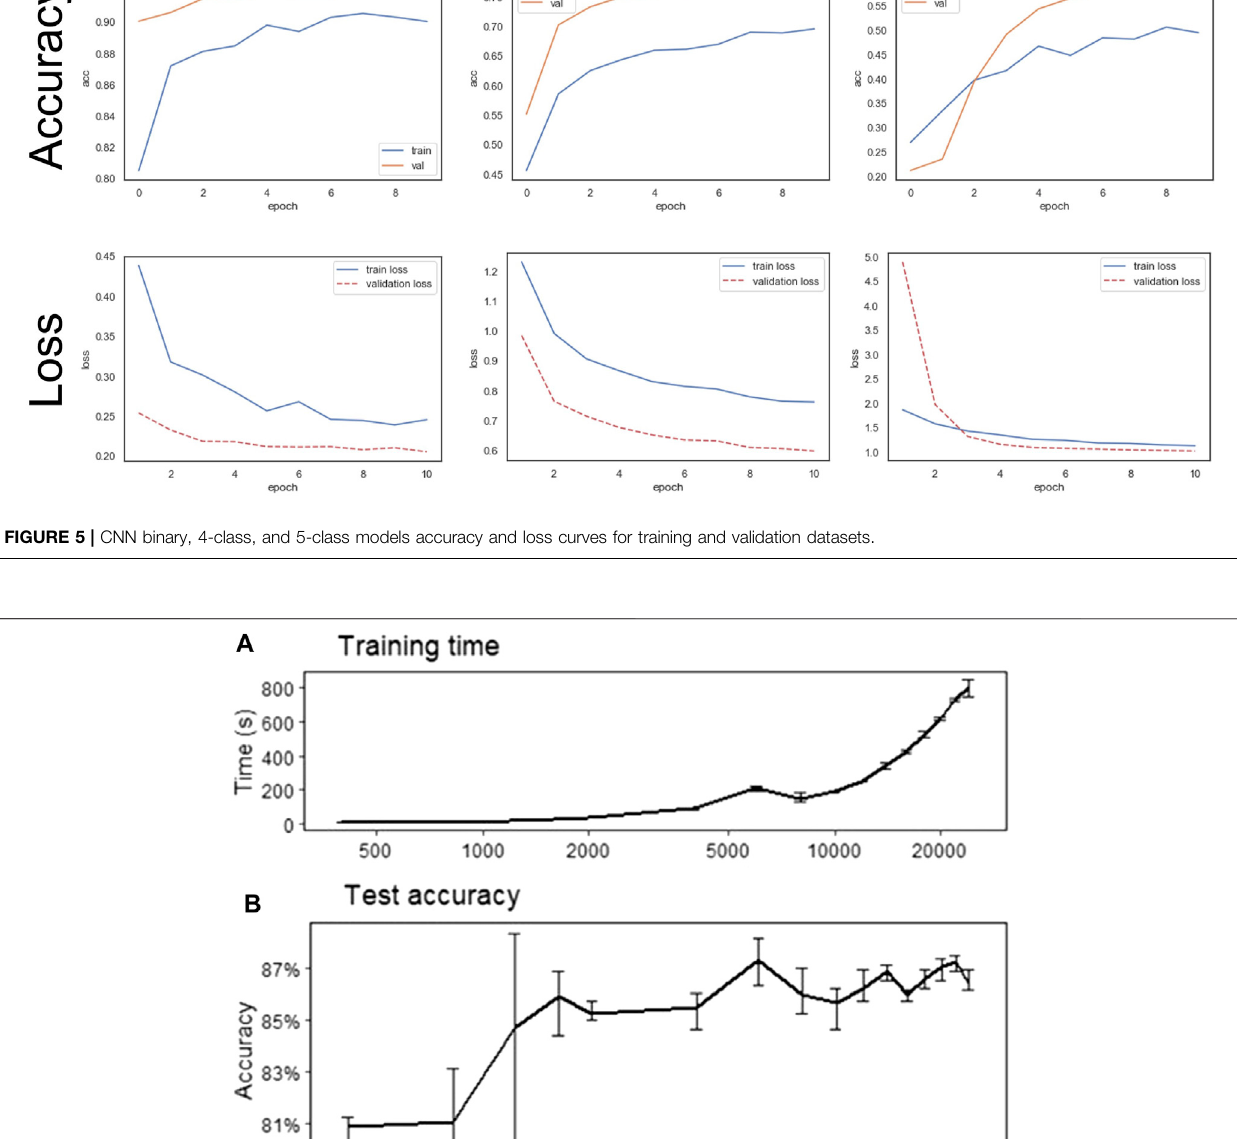
accuracy. Figure 4 displays the averaged test accuracy against the total number of observations (training + testing data) used in the model. For each model, the speci fi ed number of observations was randomly selected from the speci fi ed classes, the model was